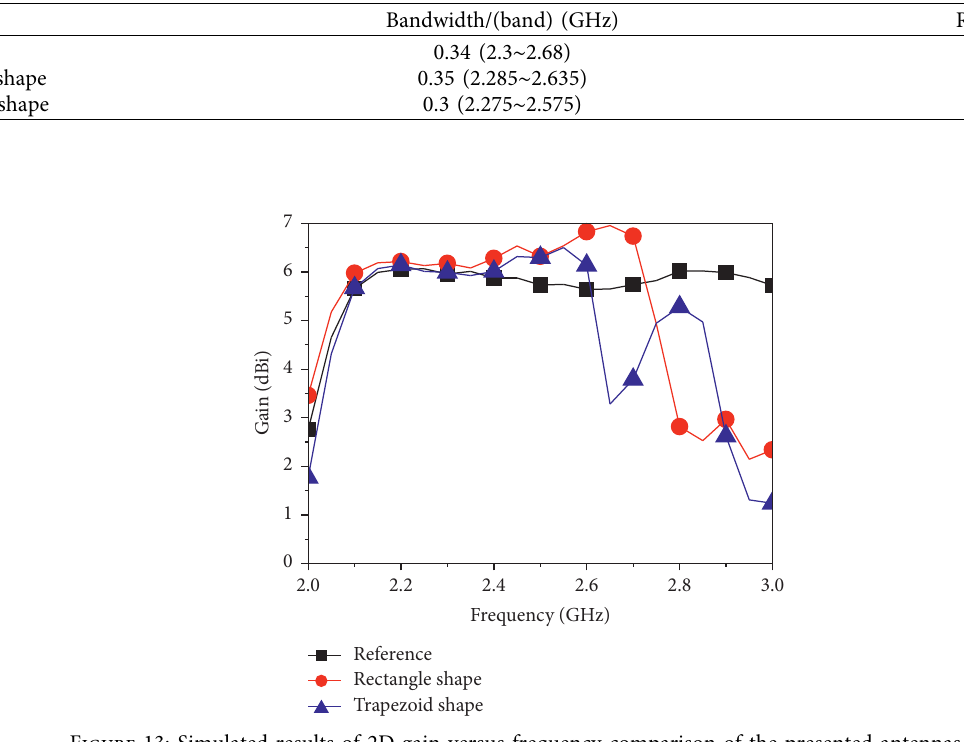
Table 1: Detailed comparison of the presented antennas.